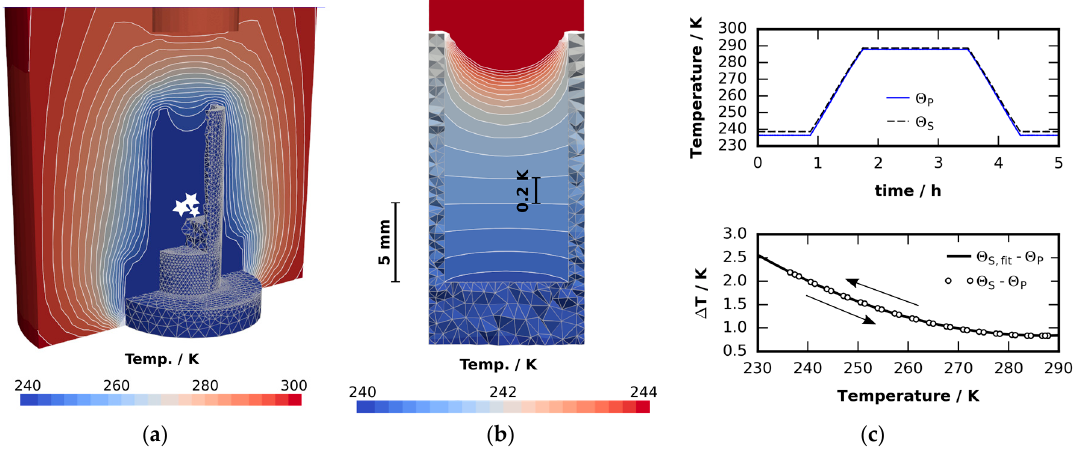
Figure 10. Thermal analysis of the pressure-monitored cooling stage obtained from a numerical solution of the 3D heat equation: ( a ) Temperature field inside the cooling stage as well as in the insulation layer and the tip of the pressure senor. White stars indicate the sample particles; ( b ) Temperature field inside the cell in the absence of a sample. Note the small temperature gradient of approximately 0.1 K/mm in the lower part where the particles are usually placed for the µCT investigation; ( c ) Sample temperature Θ (cid:2903) and Peltier element temperature Θ (cid:2900) in a thermal cycling experiment. The lower graph shows the difference Θ (cid:2903) − Θ (cid:2900) as a function of Θ (cid:2900) . No hysteresis effects can be observed.